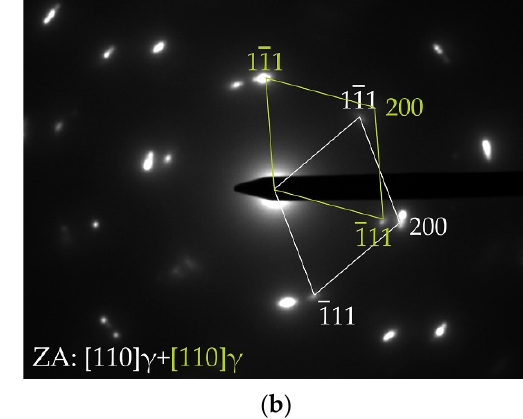
Figure 7. TEM images of steel microstructure after HTMT-3 in the section perpendicular to TD. BF image with fragmented plates ( a ), SAED patterns with marked two [110] γ zone axes ( b ).